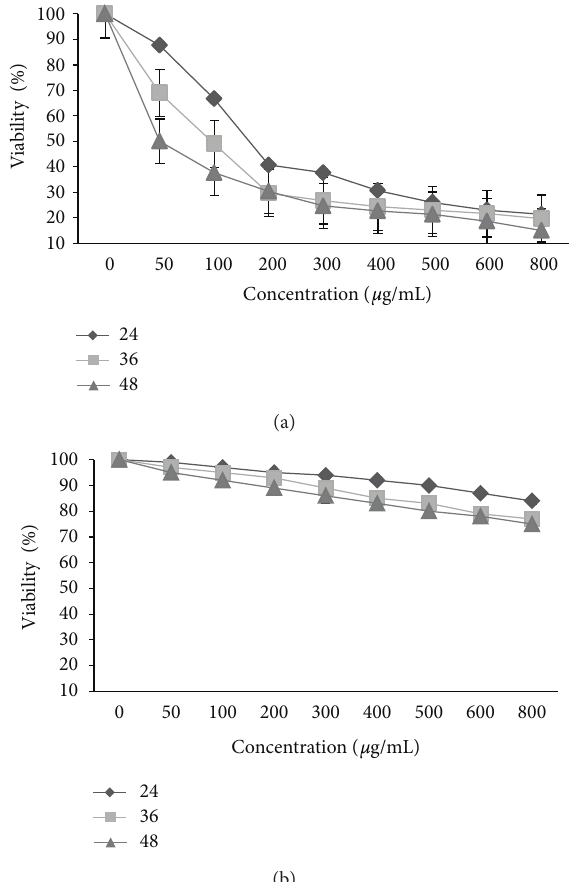
F 2: Effects of E . platyloba viability of WEHI-164 cells (a) and